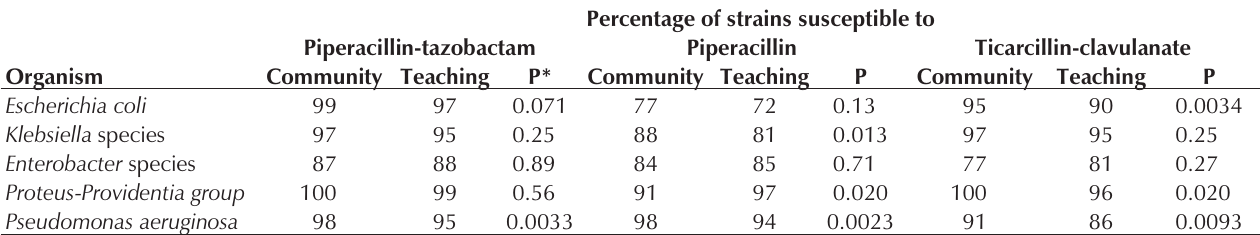
Comparative activity of piperacillin-tazobactam and other parenterally administered antibiotics against aerobic Gram-negative bacilli isolated in community and teaching hospitals